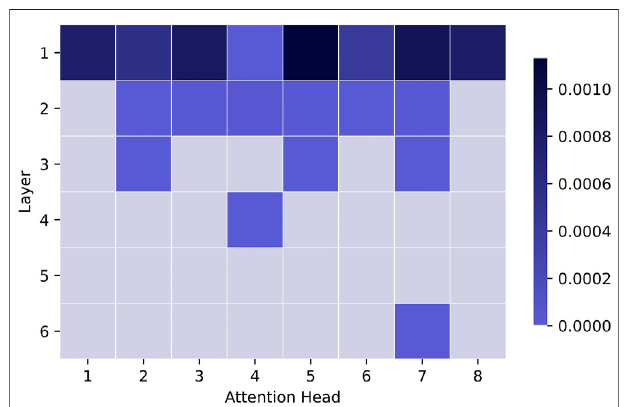
FIGURE 10 | We show the normalised entropy of visual self-attention heads. The result has been normalised by the maximum attainable entropy log( N ). The darker colour indicates higher